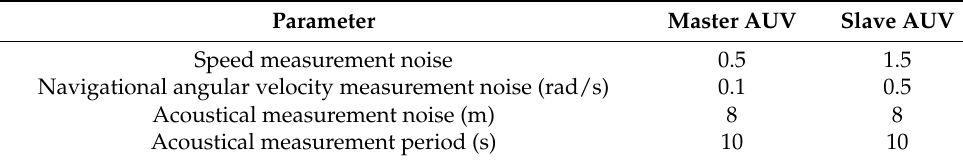
Table 1. Master and slave AUV-related parameters.